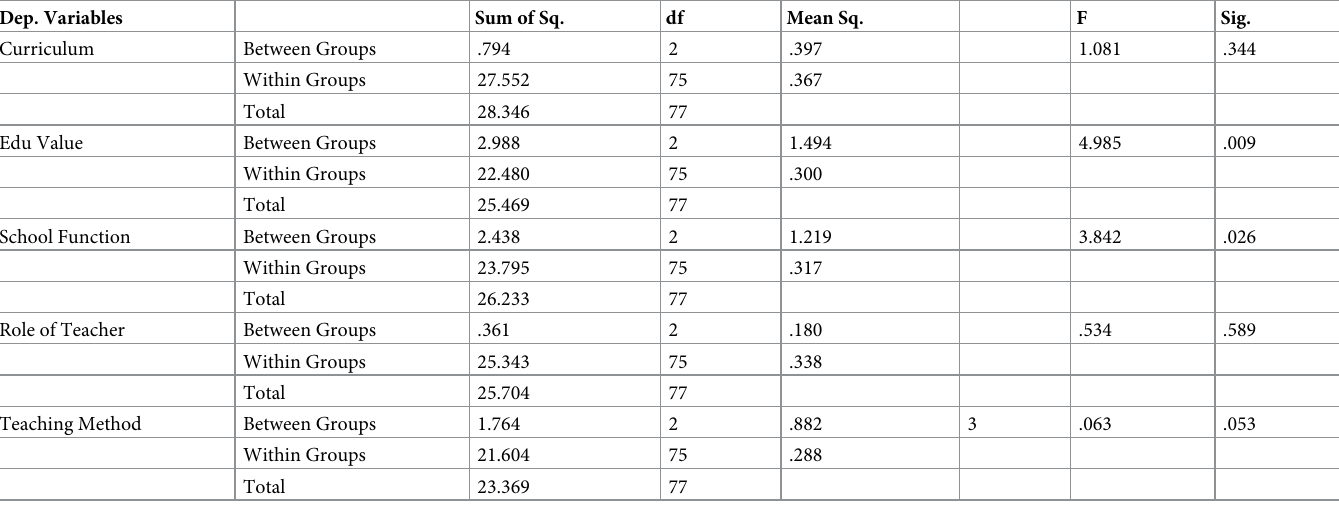
Table 12. Comparison of teachers with teaching cycles with respect to the five categories. Dep. Variables